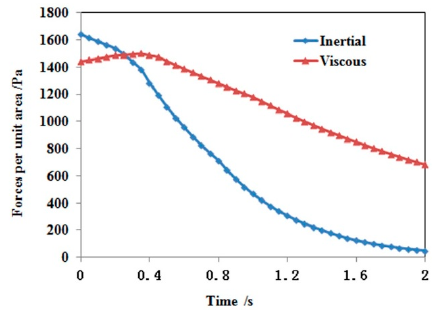
Figure 2. The comparison between inertial and viscous forces at the jetting front.